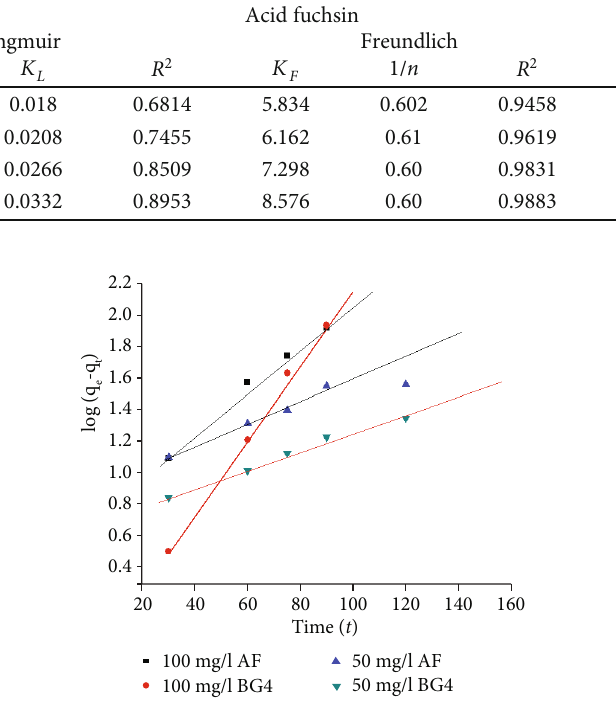
Figure 13: Pseudo fi rst order model of AF and BG4 adsorption onto